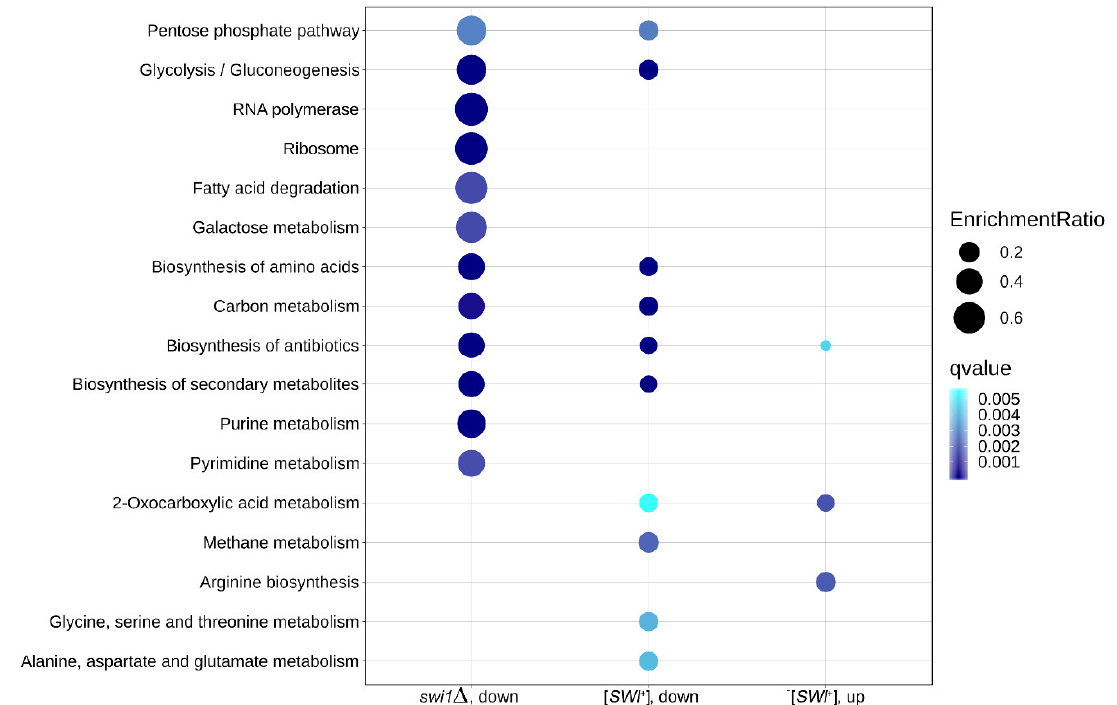
Figure 7. Over-represented KEGG Pathway term found in this work. Dot size represents the enrichment ratio, and color gradient depicts the experimental q-value in the respective assay. Pathways are sorted in descendant order based on the total enrichment ratio in all three categories.